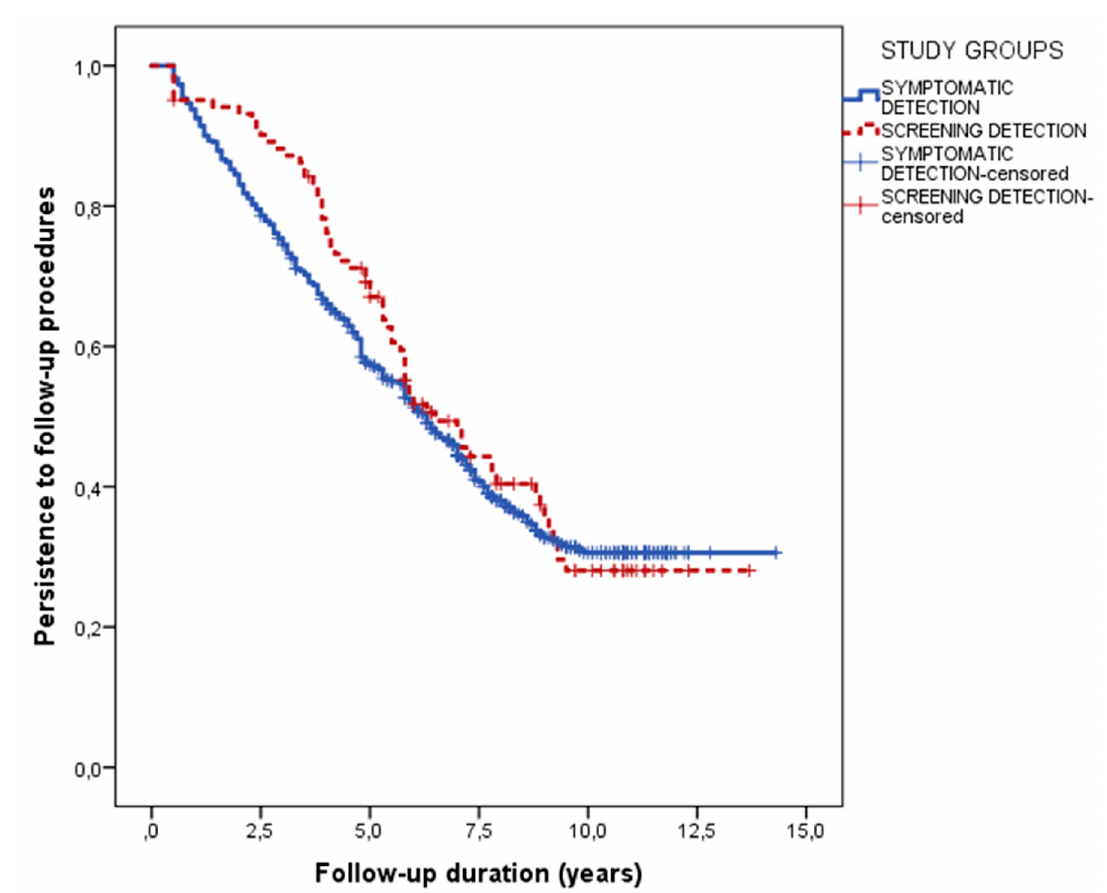
Figure 2. Persistence in the follow-up procedures in patients detected by screening and in patients diagnosed because of clinical suspicion.